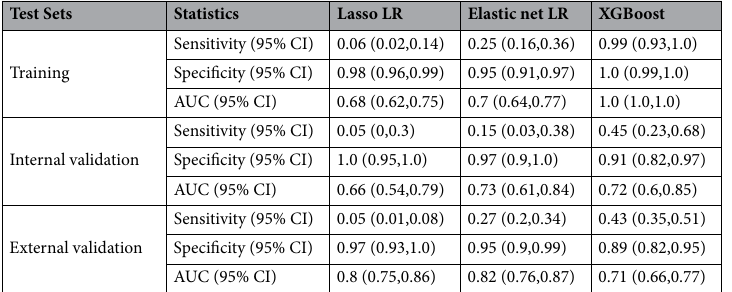
Table 4. Model performance in the training, internal and external validation sets for in-hospital mortality for patients over 50. The cutoff threshold to determine sensitivity and specificity was 0.5